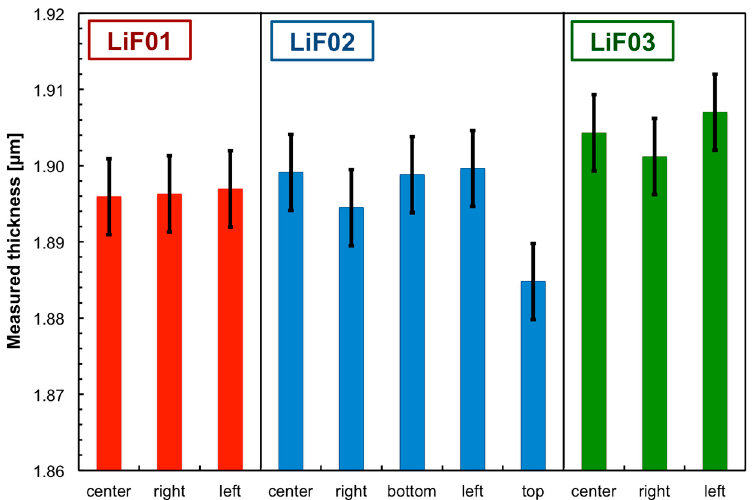
Figure 7. 6 LiF thickness measured for the three thin samples in the positions indicated by Figure 6. The nominal value was 1.8 µm.